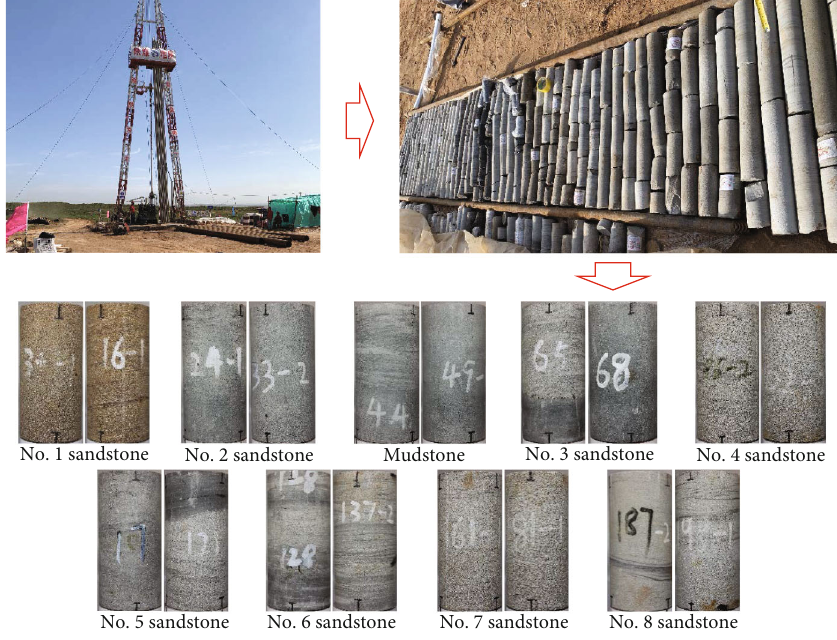
Figure 1: Rock core and standard specimens of all rock